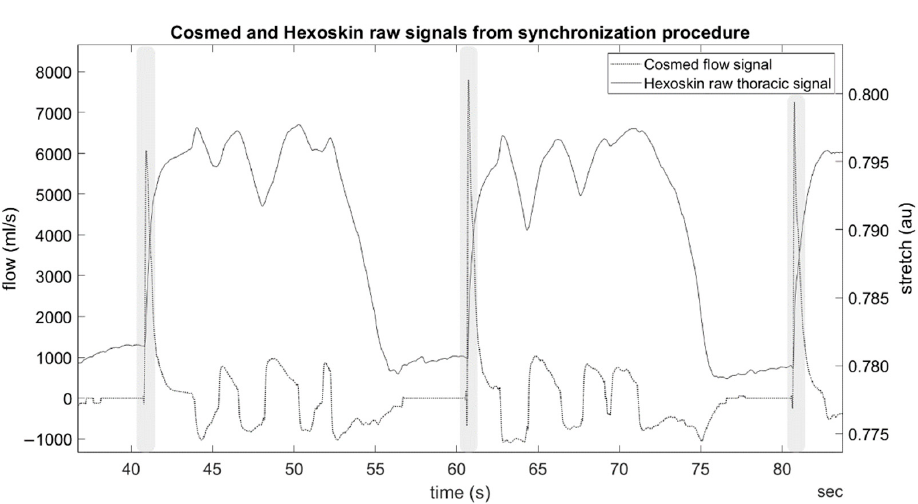
Figure 2. Example synchronization procedure sensor signals from one participant. Shaded areas indicate location of forced exhale within procedure. Au: arbitrary units.